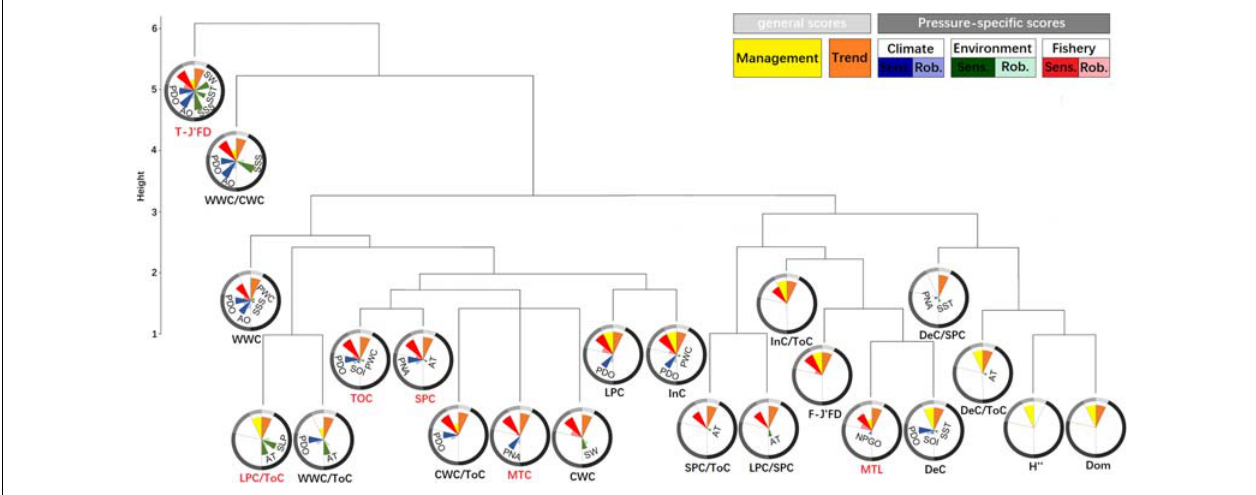
FIGURE 2 | Dendrograms from hierarchical cluster analyses of fishery ecological structure indicators of the YS. For each indicator nightingale rose diagrams are displayed to visualize their performance scores. Sensitivity (opaque color) and robustness (transparent color) scores are shown individually for each significant pressure. The length of the bars represents the percentage of achieved score from the maximum with the boundary line indicating the 100%.